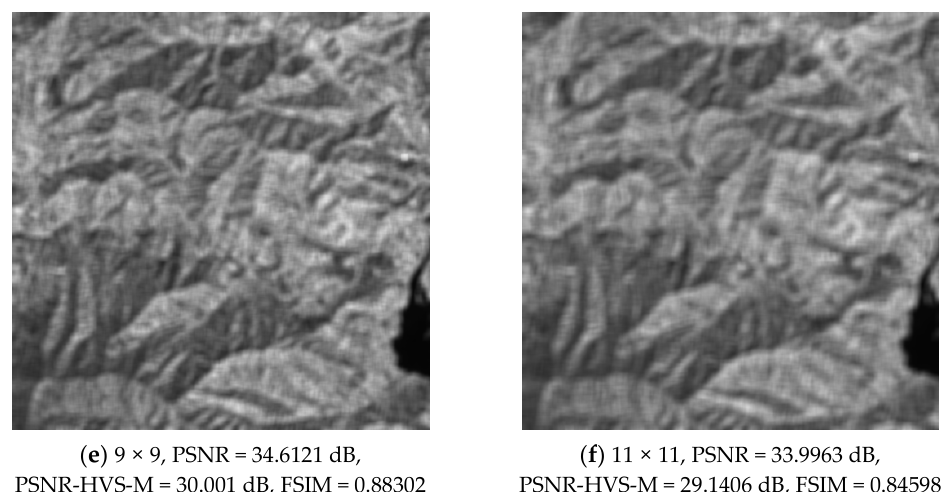
Figure 4. Noise-free ( a ), noisy ( b ), and filtered ( c – f ) images (example 3). Figure 2 gives an example of the situation when the processed image is of a middle complexity. The Lee filters with all four scanning window sizes produce improvements of all three considered metrics (compared to the noisy image, metrics’ values are placed below the corresponding images). The best (the largest) PSNR is provided by the 9 ×